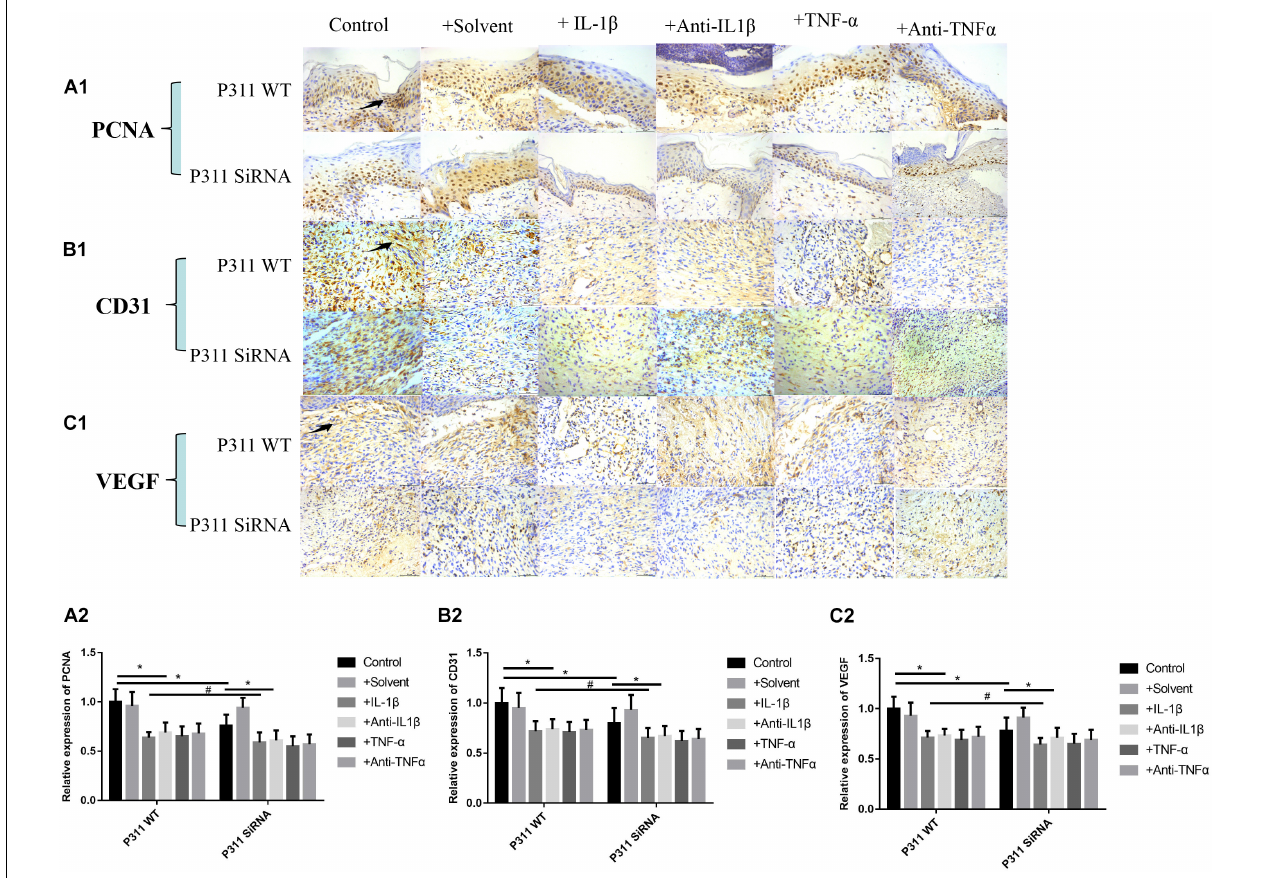
FIGURE 9 | Effect of different stimulus factors on the expression of PCNA, CD31, and VEGF in wound tissues. Mean ± standard deviation (SD) denote the experimental results; * indicates P < 0.05, # indicates P > 0.05. (A1) Representative IHC stains for PCNA in wound tissues under different stimulus factors. (B1) Representative IHC stains for CD31 in wound tissues under different stimulus factors. (C1) Representative IHC stains for VEGF in wound tissues under different stimulus factors. (A2) Quantitation of the PCNA levels in A1 . (B2) Quantitation of the CD31 levels in B1 . (C2) Quantitation of the VEGF levels in C1